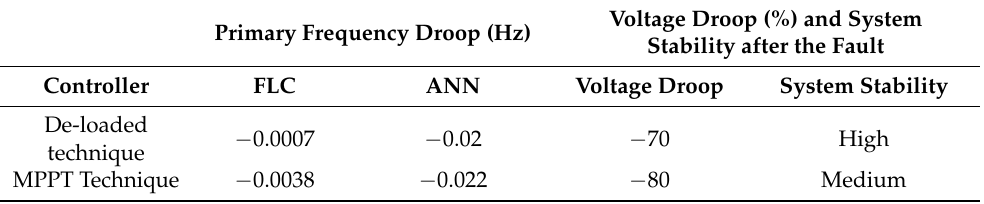
Table 2. Quantitative comparison between FLC and ANN with both techniques.